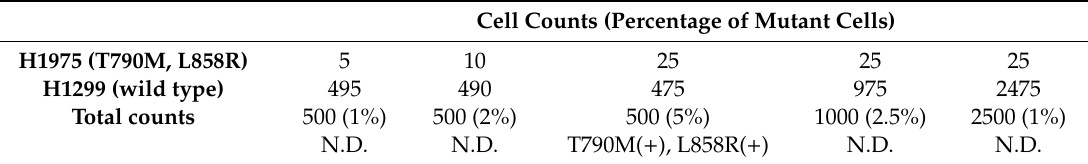
Table 1. Detection of EGFR mutation.